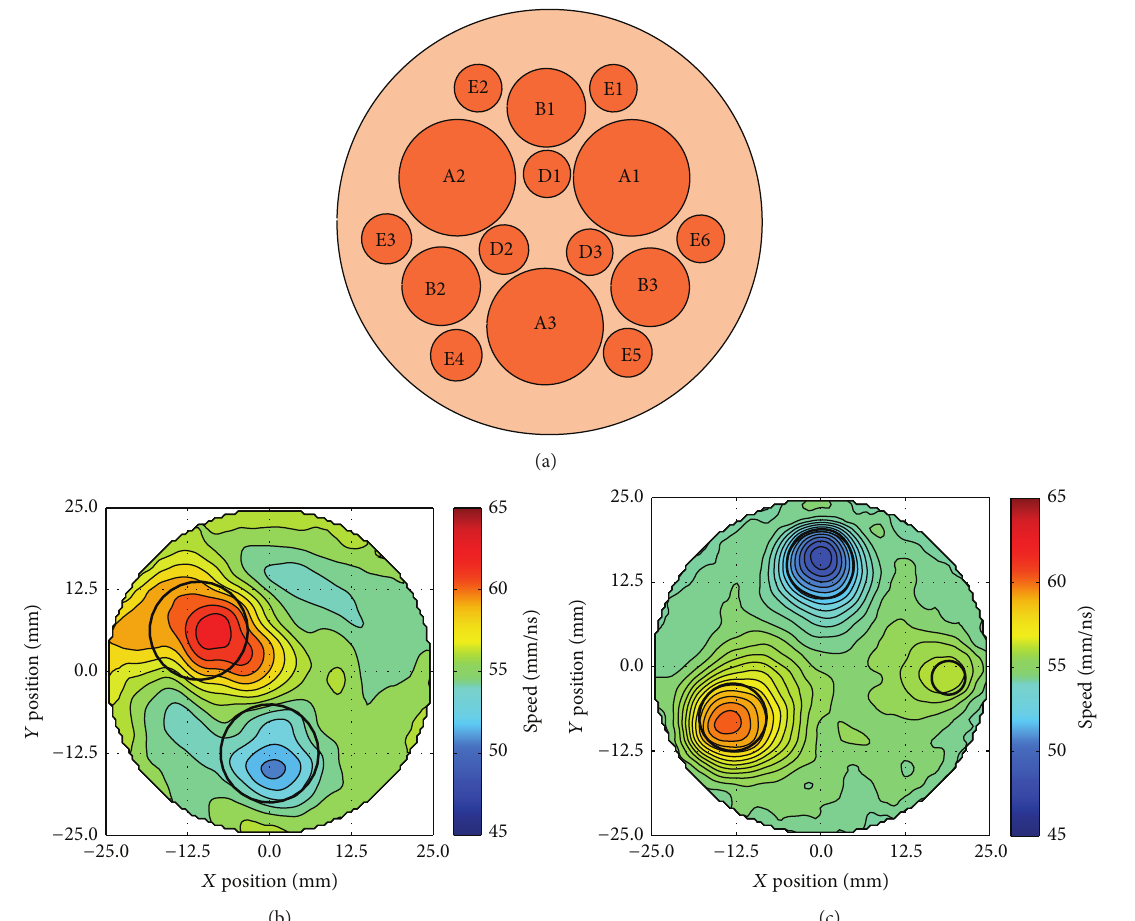
Figure 9: (a) Top view of phantom used in experiments for obtaining speed maps. Inclusions labeled A, B, D, and E of different sizes and at different locations can be inserted in the medium for obtaining regions with scattering coefficient differing from that of the otherwise homogeneous background. In the results given in (b) and (c), the background’s reduced scattering coefficient has value 𝜇 󸀠 𝑠 = 5 cm −1 . (b) Speed map obtained with inclusion A2 having 𝜇 󸀠 𝑠 = 2.5 cm −1 and A3 with 𝜇 󸀠 𝑠 = 10 cm −1 . (c) Speed map with inclusions B1, B2, and E6 having, respectively, 𝜇 󸀠 𝑠 = 20 cm −1 , 2.5 cm −1 , and 2.5 cm −1